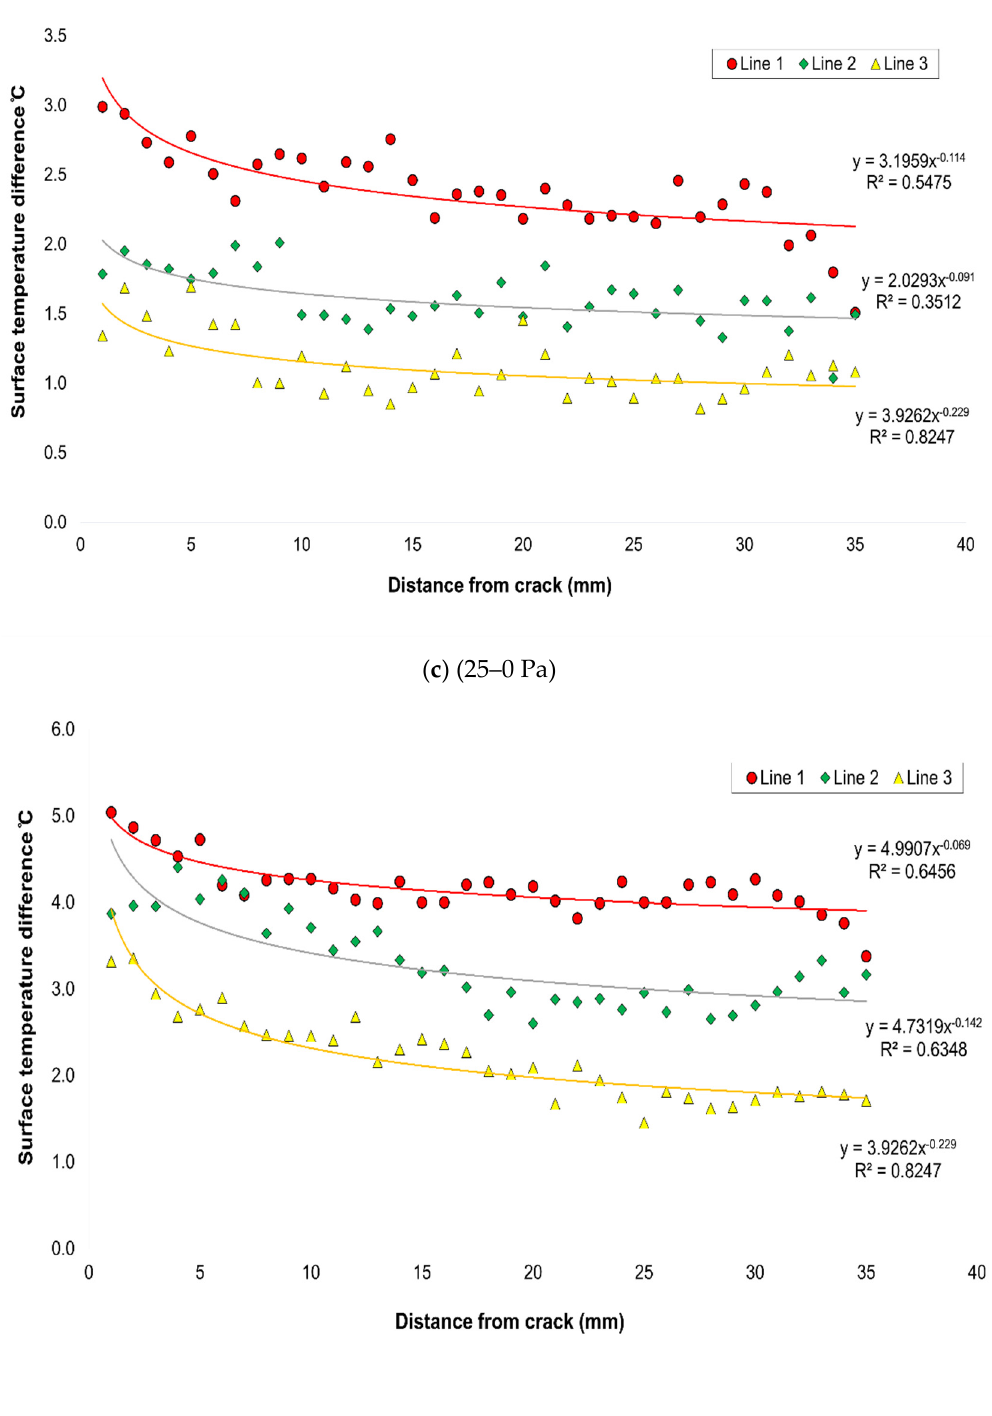
Figure 7. ( a ) Paths of air leakage analyzed, and the surface temperature differences vs. the distance from the crack at: ( b ) 15–0 Pa, ( c ) 25–0 Pa, and ( d ) 65–0 Pa.